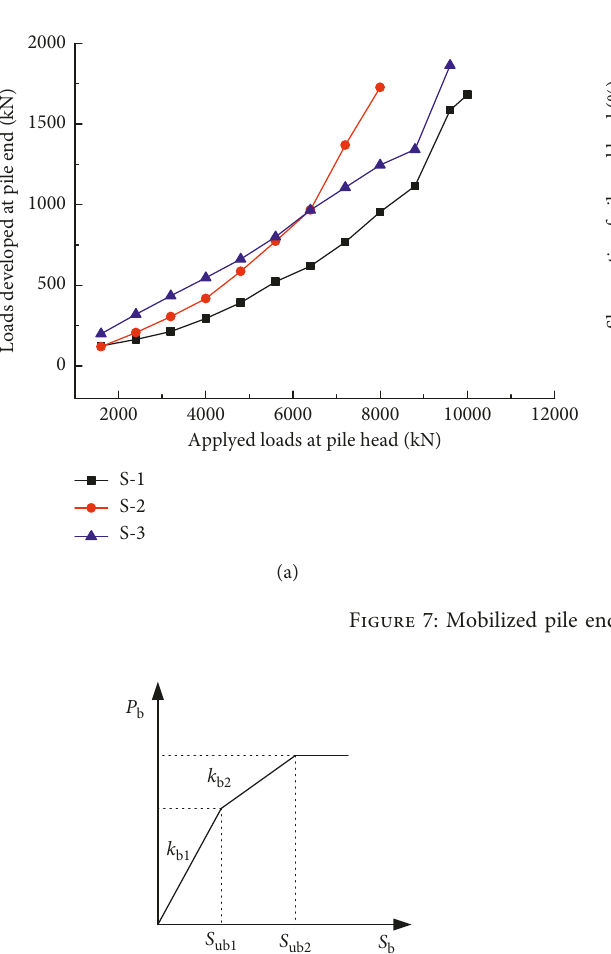
Figure 8: Trilinear model of the relationship between the pile base load and pile base